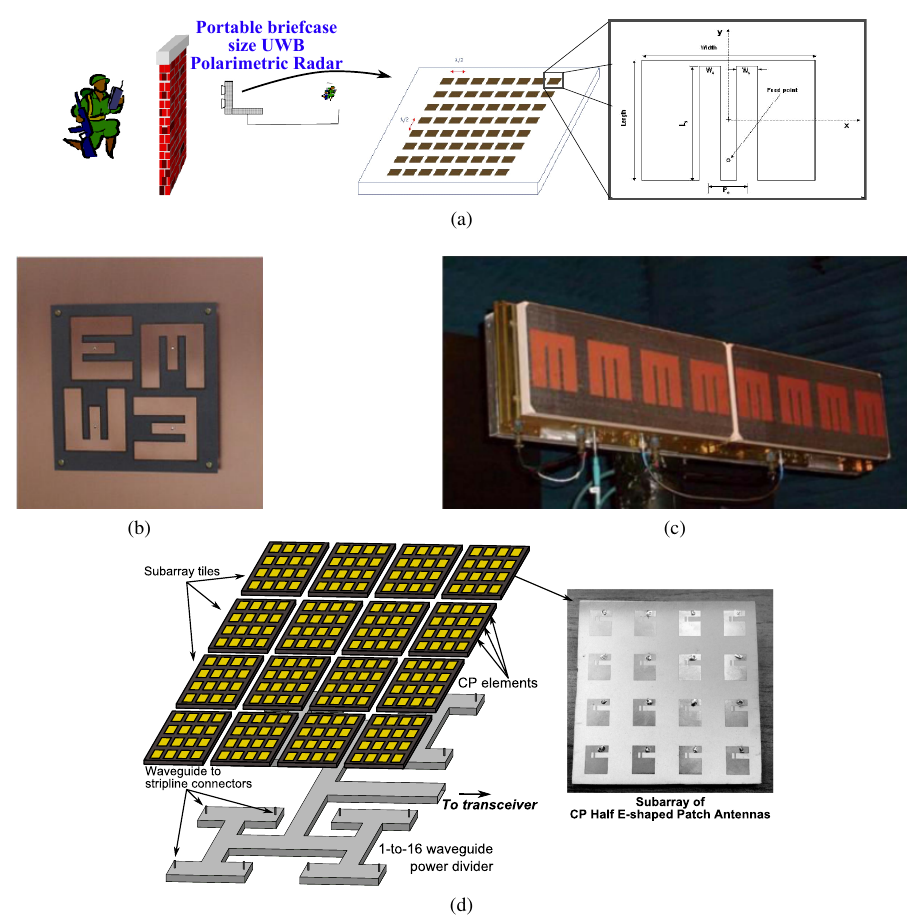
FIGURE 26. E-shaped patch antennas and variations for high performance array applications. (a) E-shaped patch antennas for through-wall microwave imaging (TWMI) at 2 GHz [35]. (b) Sequentially-rotated array for GPS [36]. (c) Wideband null steering array [37]. (d) Array for Direct-to-Earth links for Mars Rovers